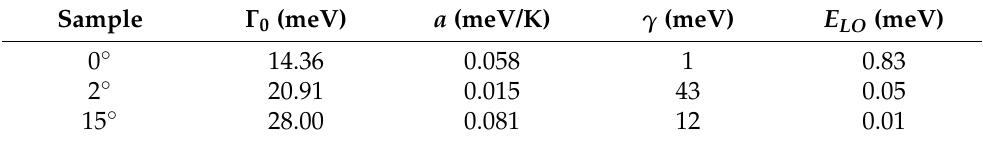
Figure 9. PL full width at half maximum (FWHM) as a function of 1000/T of the InGaAs/GaAsP QWs on substrates misoriented by ( a ) 0°, ( b ) 2°, and ( c ) 15°. The fitting curves of the FWHM data of the PL spectra are predictions based on the exciton–optical phonon coupling model. Table 2. FWHM-fitting parameters for samples with different misoriented substrates.